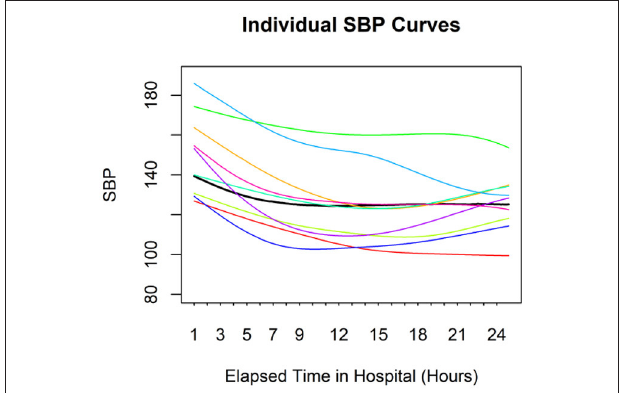
FIGURE 1 | Individual SBP curves for nine random individuals. The black line represents the average curve for the entire sample. There is considerable variation among individuals.